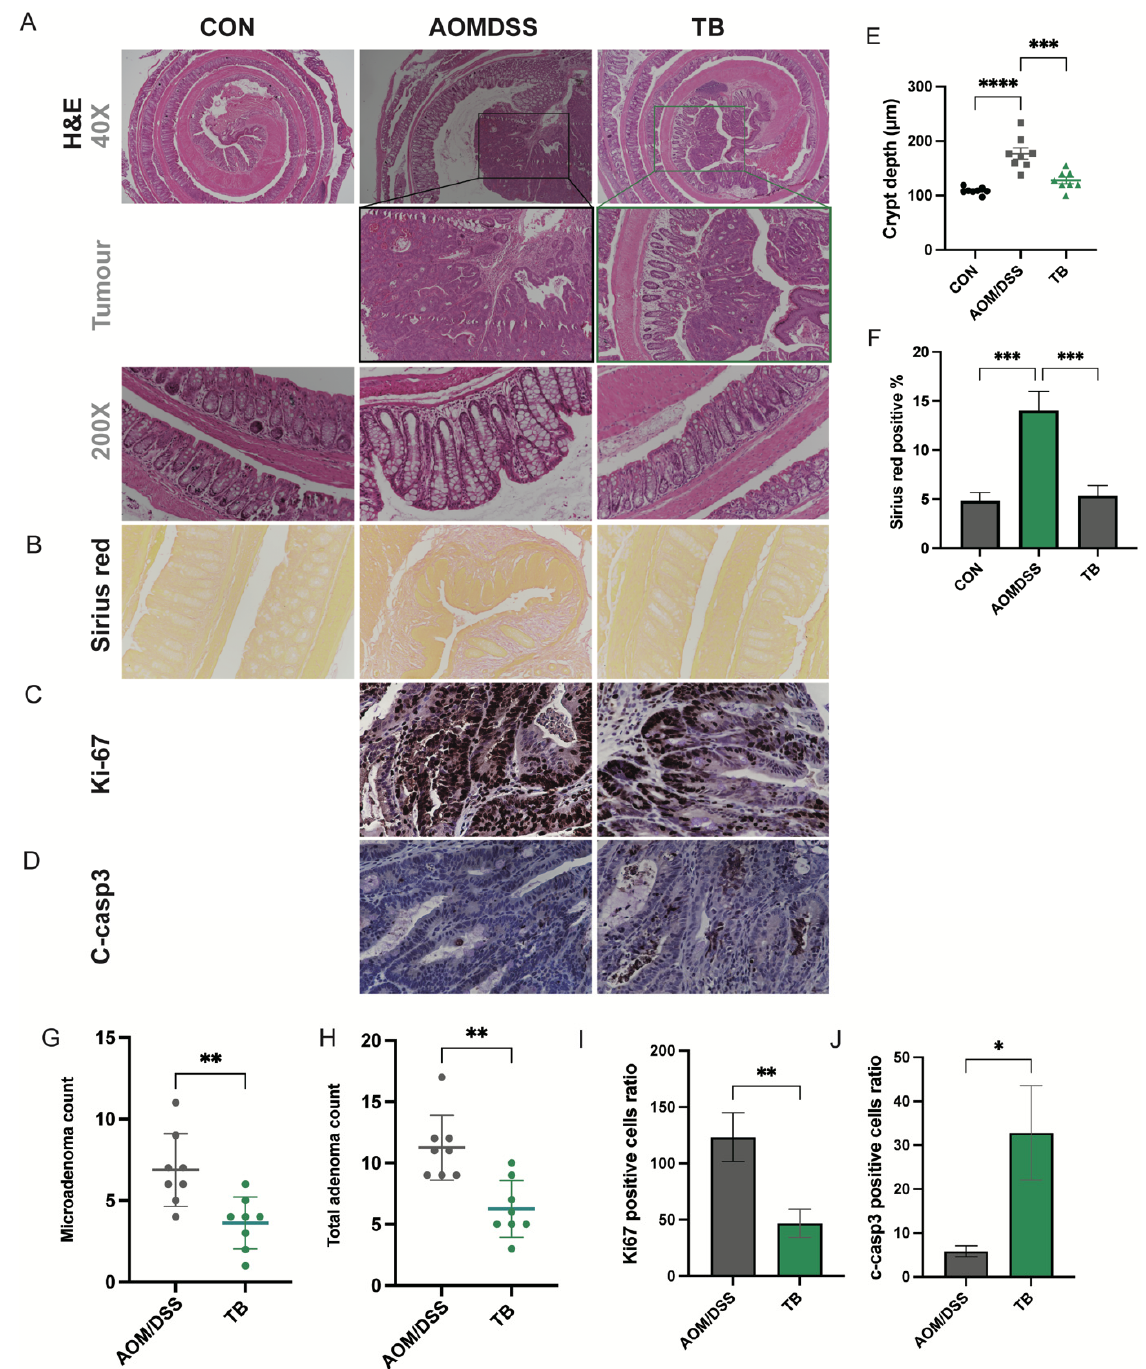
Figure 2. TB suppresses colon cancer progression. Representative photos of H&E staining of ( A ) colon tissue, 40×, tumor areas, 100× and Colon crypt, 200×. ( B ) Representative photos of Sirius red staining of colon tissues. IHC detection of ( C ) Ki67 and ( D ) C-casp3 in tumor areas. ( E ) Colon crypt depth ( μ m). ( F ) Quantification of Sirius red-positive areas. ( G ) Total adenoma count. ( H ) Total adenoma count per mouse. Positive cell ratio of ( I ) Ki67 and ( J ) c-casp3. n = 7–8 per group * p < 0.05, ** p < 0.01; *** p < 0.001, **** p < 0.0001.